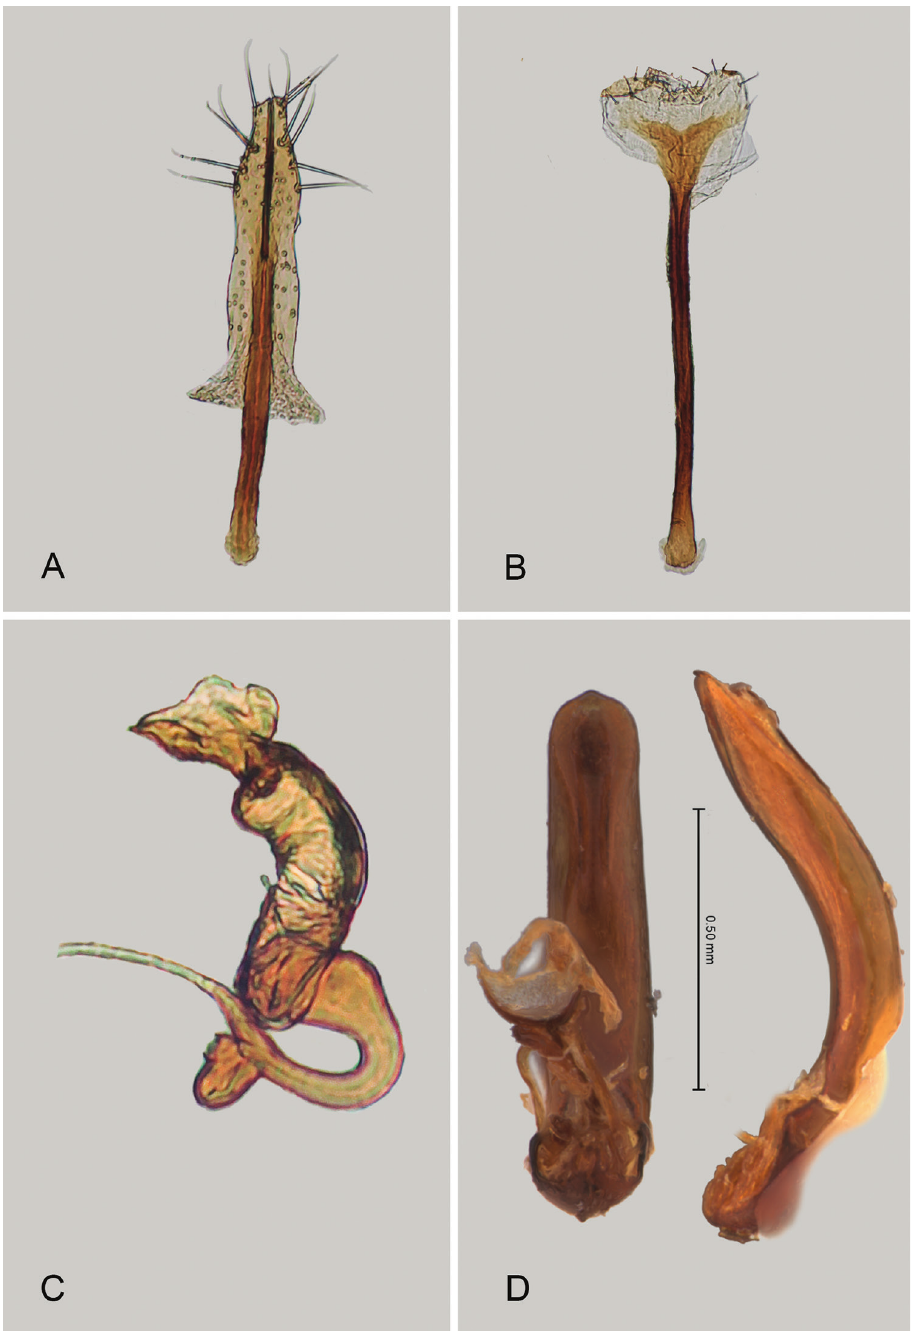
Figure 6. Andersonoplatus bechyneorum . A Vaginal palpi B Tignum C Spermatheca D Median lobe of aedeagus, ventral and lateral